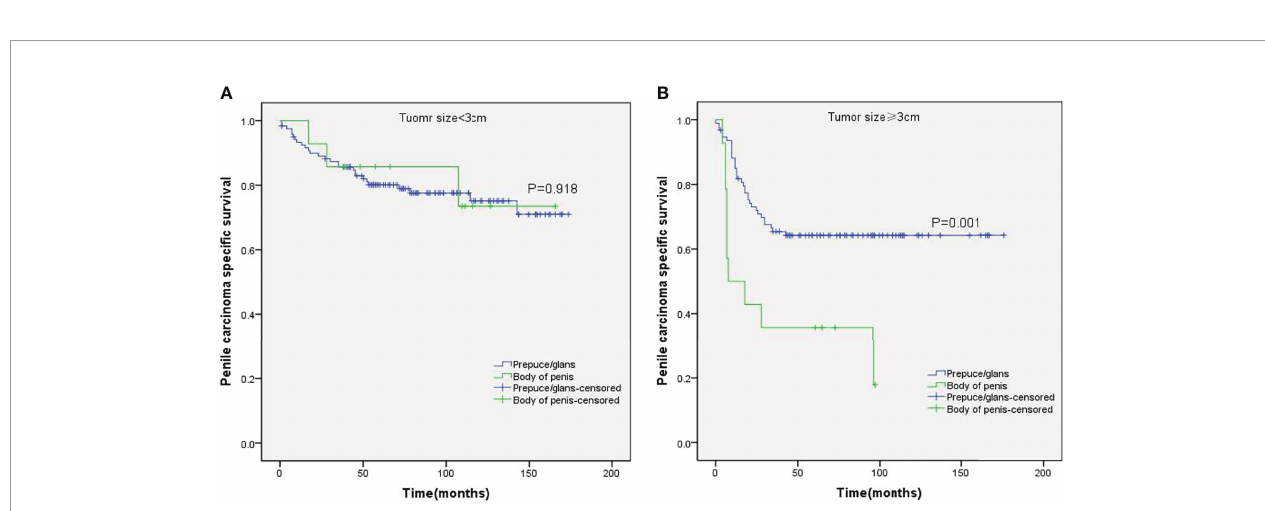
FIGURE 5 | Kaplan – Meier analyses of penile carcinoma-speci fi c survival on tumor size < 3 cm group (A) and tumor size ≥ 3 cm group (B) in patients strati fi ed by tumor